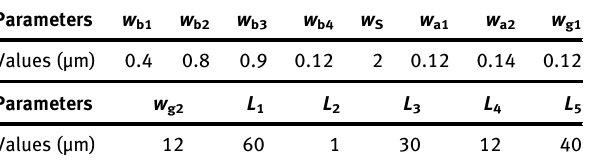
Table  : Key parameters of the designed polarization switch.